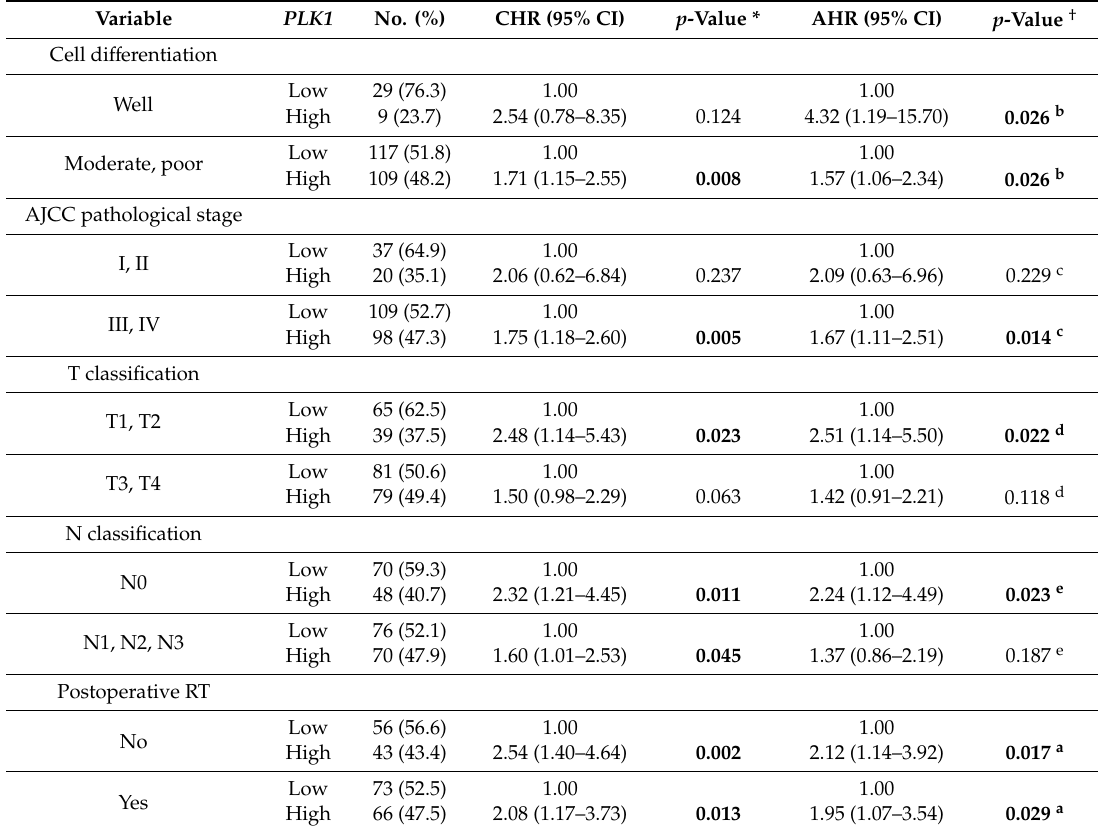
The gene expression data and clinical information of OSCC are obtained from the TCGA dataset. Abbreviations: SCC, squamous cell carcinoma; CHR, crude hazard ratio; CI, confidence interval; AHR, adjusted hazard ratio; AJCC, American Joint Committee on Cancer; RT, radiotherapy. * p -values were estimated by Cox’s regression. † p -values were estimated by multivariate Cox’s regression. a Adjusted for cell di ff erentiation (moderate + poor vs. well) and